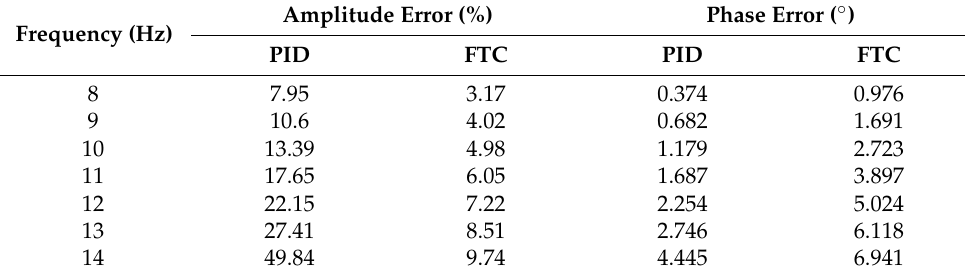
Table 1. Comparison chart of system performance with 1° amplitude.